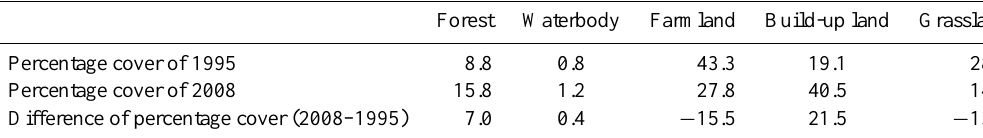
Table 2. Percentage cover of different Land use for 1995 and 2008.